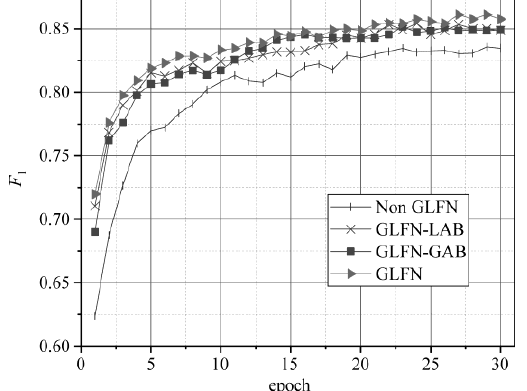
Table 1. The effect of different t values on F1 of GLFN-GAB and GLFCNN on the SemEval-